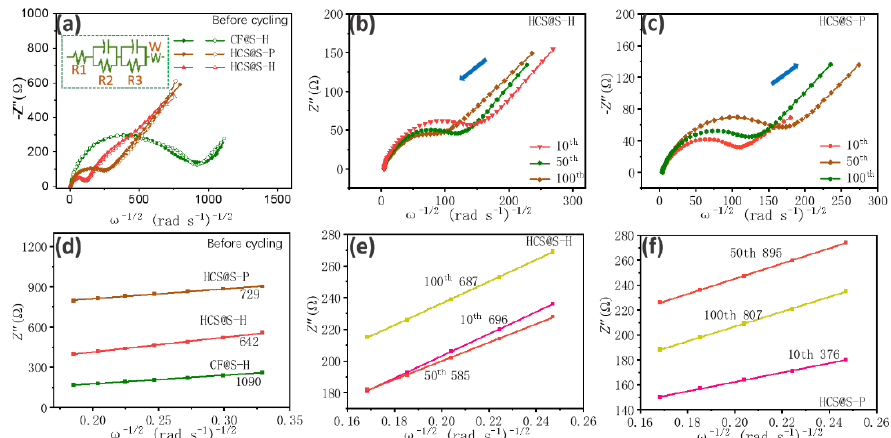
Figure 7. Nyquist plots of the as-resulted samples. Nyquist plots and fitting lines before cycling ( a ), Nyquist plots at different cycles for HCS@S-H ( b ), CF@S-H ( c ), their linear relationship between w −1/2 and Z’’ for the as -resulted samples before cycling ( d ), at different cycles for HCS@S-H ( e ) and CF@S-H ( f ).